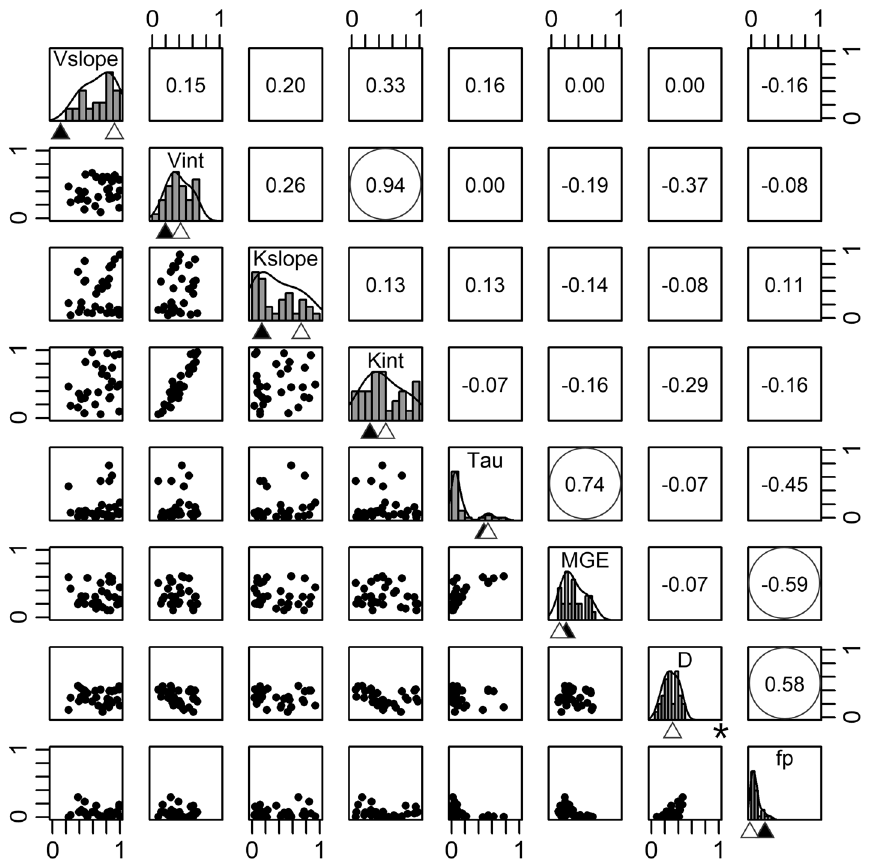
Figure 3. MIMICS model parameter space and relationships among parameters in the parameter ensemble that produced similarly accurate (RMSE 1.8–2.0) estimates of total soil organic C stocks across the Reynolds Creek Experimental Watershed and Critical Zone Observatory (n = 30 member parameter ensemble). Normalized parameter range coincides with the scaling factor proposal range for each parameter (see Table 1). Histograms on the diagonal represent the uncertainty in parameter estimates from the parameter ensemble. Triangles below histograms represent default (closed) and best-fit (open) parameter values. Off-diagonal panels display pairwise correlations and correlation coefficients between individual parameters, with statistically significant correlations circled ( p < 0.05). *Default parameter line for D is beyond plot scale (D default = 3.1). (Generated by free software R, https:// www.R- proje ct.